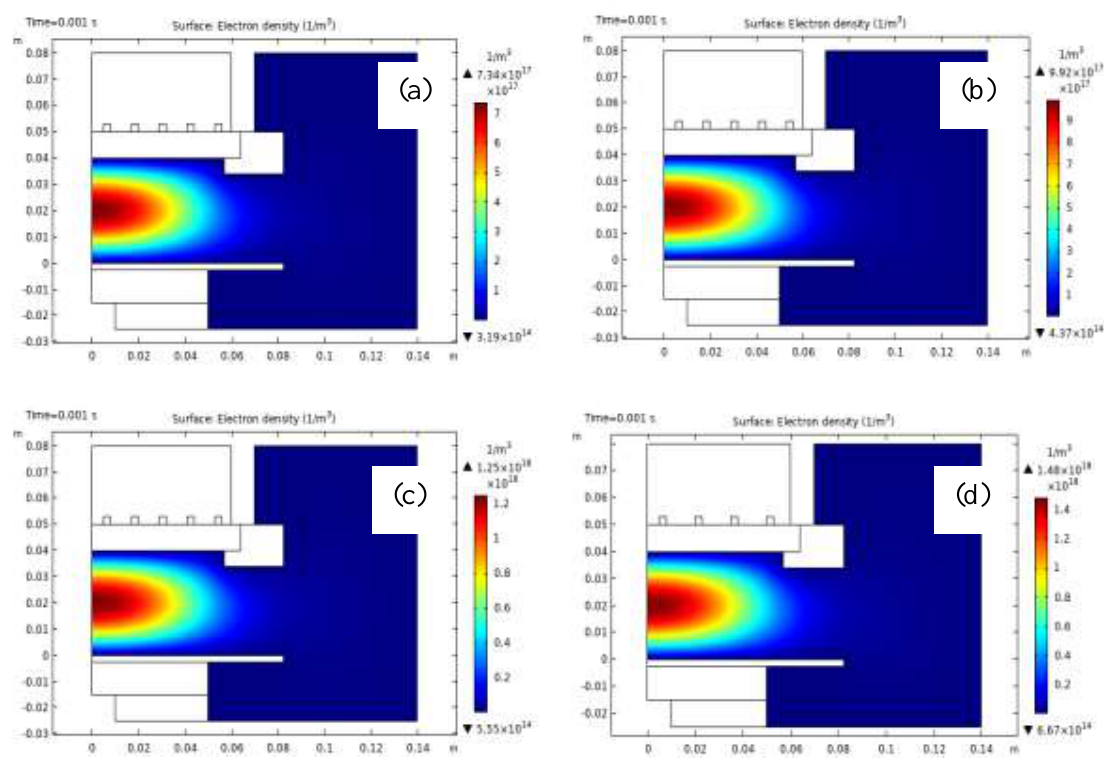
Figure 3: Electron density distribution at different power value; (a)750W, (b) 1000W, (c)